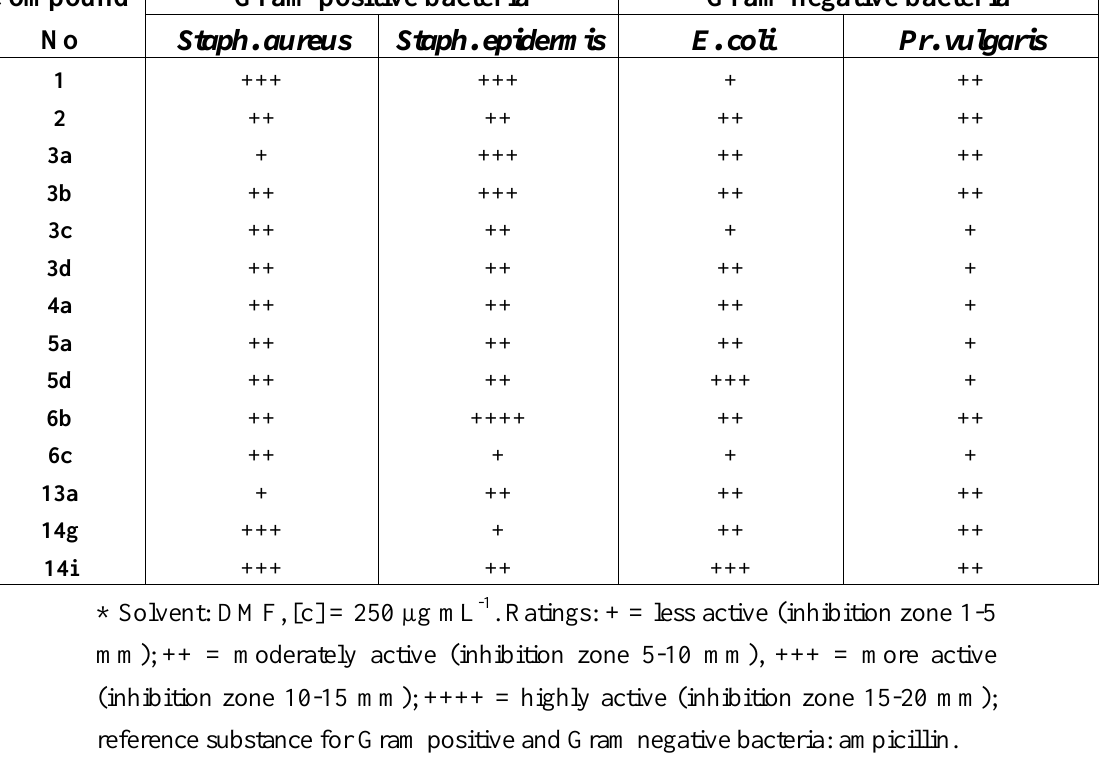
Table 5. Antibacterial activity of select compounds* Gram positive bacteria Gram negative bacteria